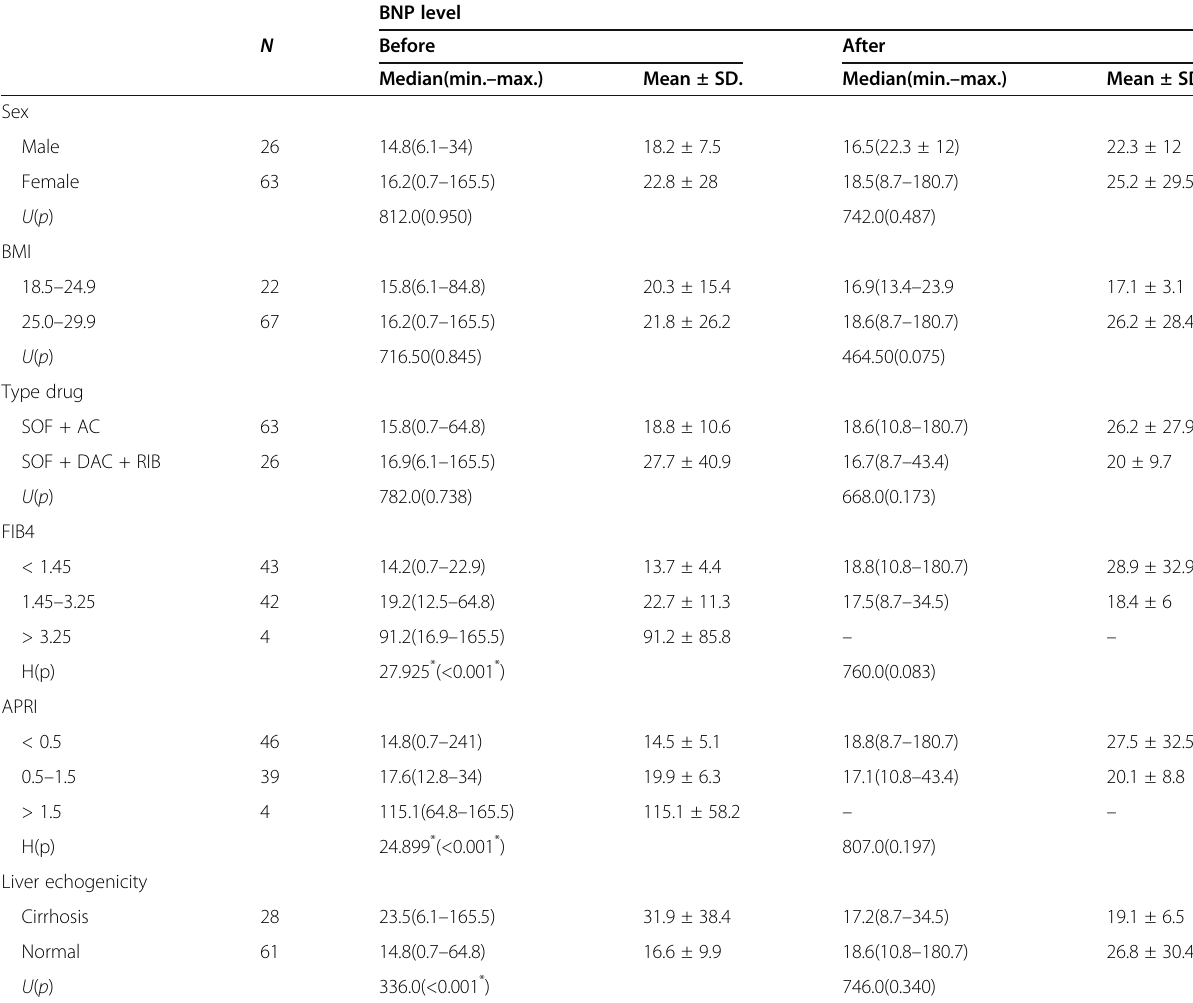
Table 4 Relation between BNP (before and after treatment) level and different parameters BNP level N Before After Median(min. – max.) Mean ± SD. Median(min. – max.) Mean ±